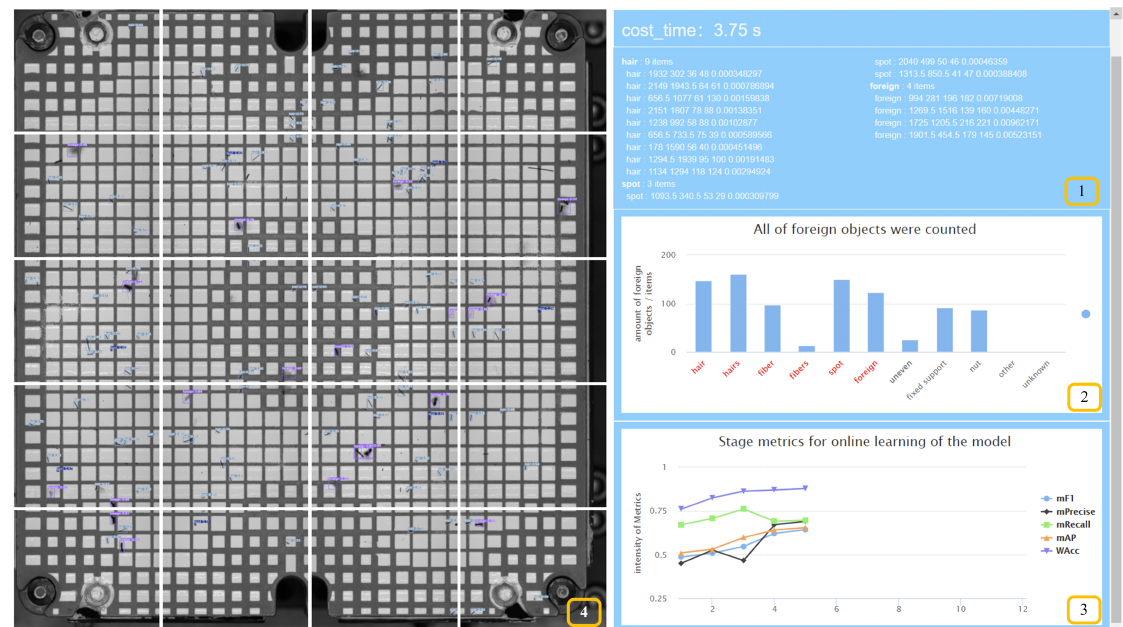
Figure 19. IGBT board surface object detection visual